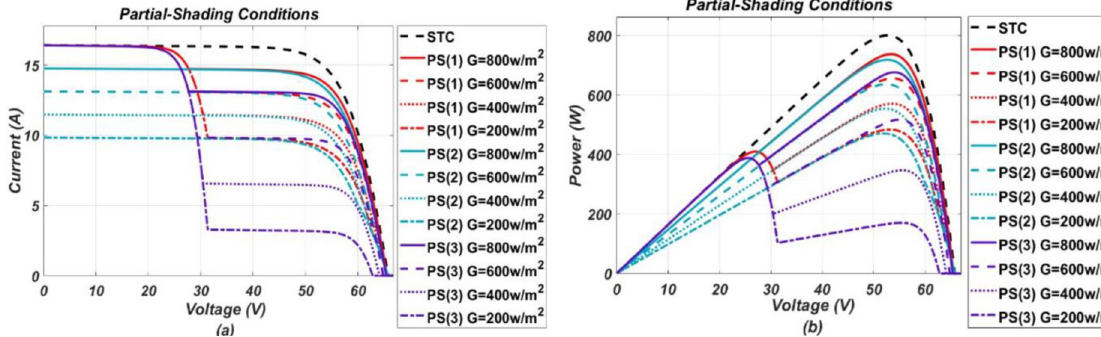
Fig 3. (a) and (b), I-V and P-V graphs respectively, representing response of P.V. system under partial shading conditions of different intensity levels.